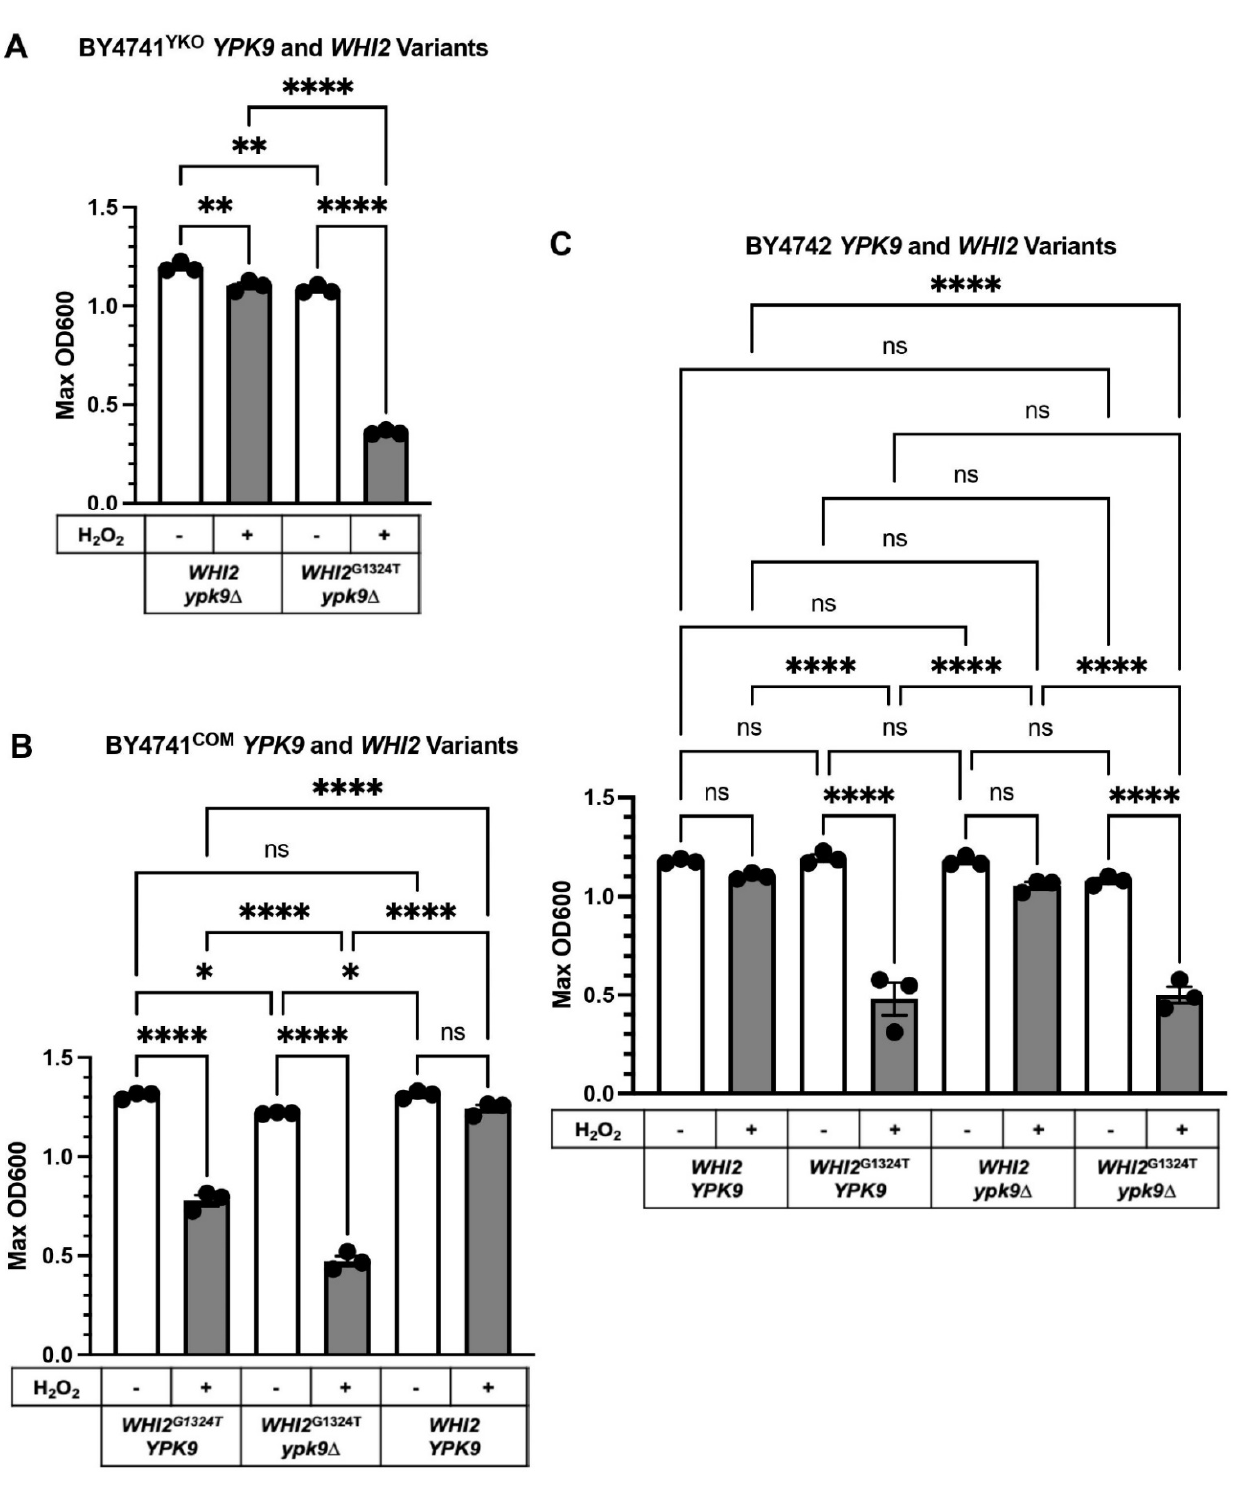
Figure 4. Effect H 2 O 2 on the growth of WHI2 and YPK9 variants in different background strains. ( A ) WHI2 variants in the YKO collection’s ypk9 ∆ in BY4741 YKO . ( B ) WHI2 variants in BY4741 COM . ( C ) WHI2 and YPK9 variants in BY4742. Hygromycin (Hyg) was used to select for gene replacement. The OD shown is the maximum recorded during 25 h of growth. Results were analyzed using one-way ANOVA and Tukey’s post hoc test. Error bars represent the SEM, n = 3. Asterisks represent p -values: * 0.03332, ** 0.0021, **** <0.0001; ns, not significant. We extended the analysis by replacing WHI2 G1324T with WHI2 in BY4741 COM and com- paring its hydrogen peroxide sensitivity to that of BY4741 COM WHI2 G1324T . As expected,